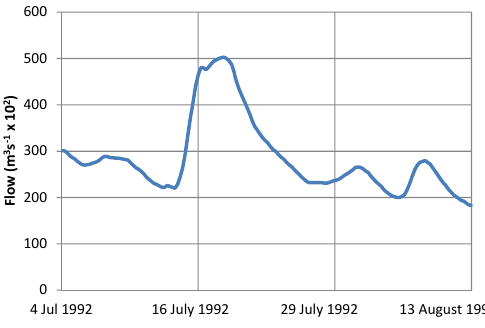
Fig 1 : Hydrograph of observed flow for Three Gorges Dam, Yangtze River, China Fig. 1. Hydrograph of observed flow for Three Gorges Dam, Yangtze River,